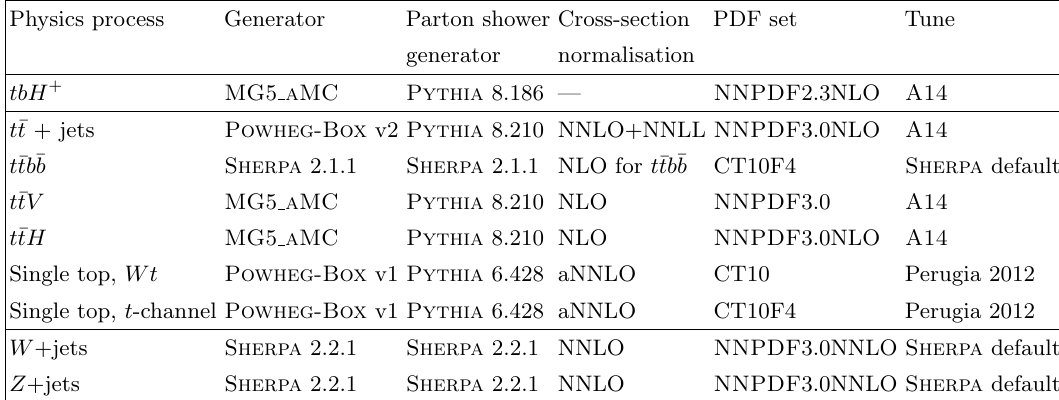
Table 1. Nominal simulated signal and background event samples. The generator, parton shower generator and cross-section used for normalisation are shown together with the applied PDF set and tune. The t (cid:22) tb (cid:22) b event sample generated using Sherpa 2.1.1 is used to reweight the events from the t (cid:22) t + (cid:21) 1 b process in the t (cid:22) t + jets sample.